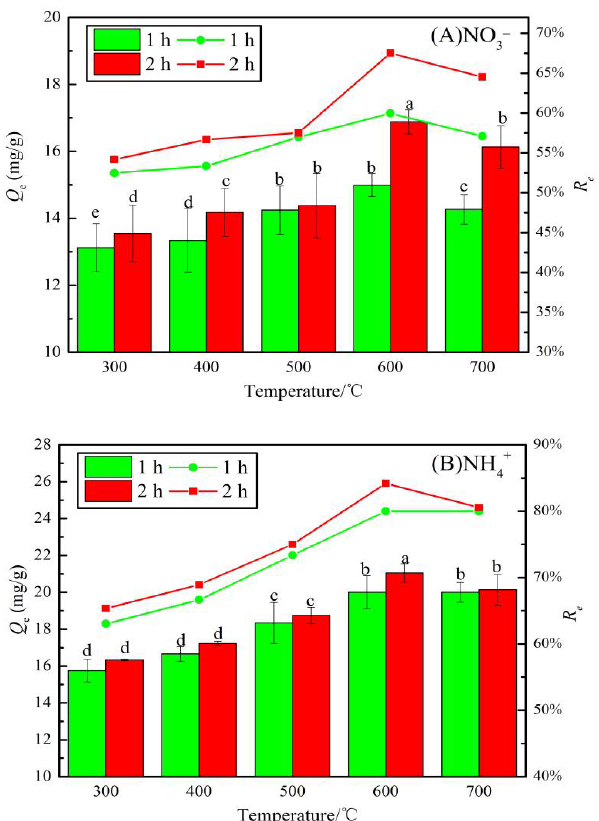
Figure 7. E ff ects of di ff erent carbonization parameters for adsorption capacity and removal rate on JB. ( A ) for NO 3 − , ( B ) for NH 4 + . Note: a, b, c, and d in the figure are the output results of one-way Analysis of Variance (ANOVA) at P < 0.05 for each